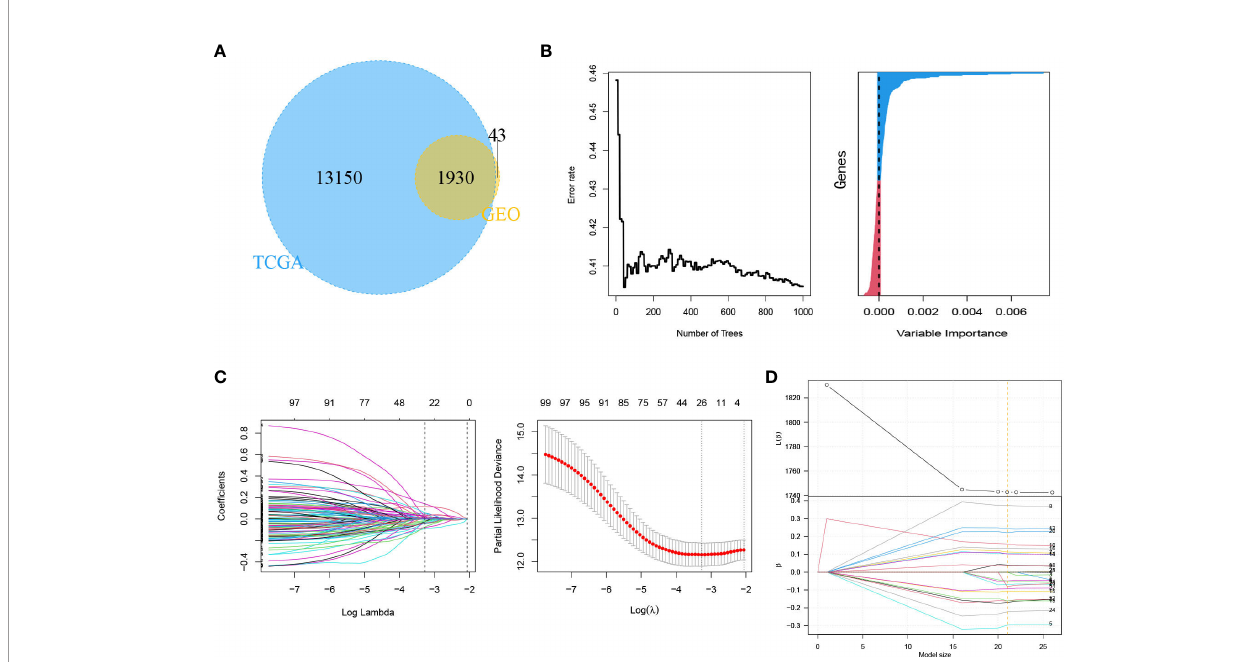
FIGURE 7 | Identi fi cation of genes in lncRNA model. (A) Venn plot of 1930 lncRNAs related to m 6 A. (B) Random survival forest analysis. (C) LASSO shrinking path diagram. (D) The coef fi cient pro fi le plot of the coef fi cient and loss paths for best subset selection.